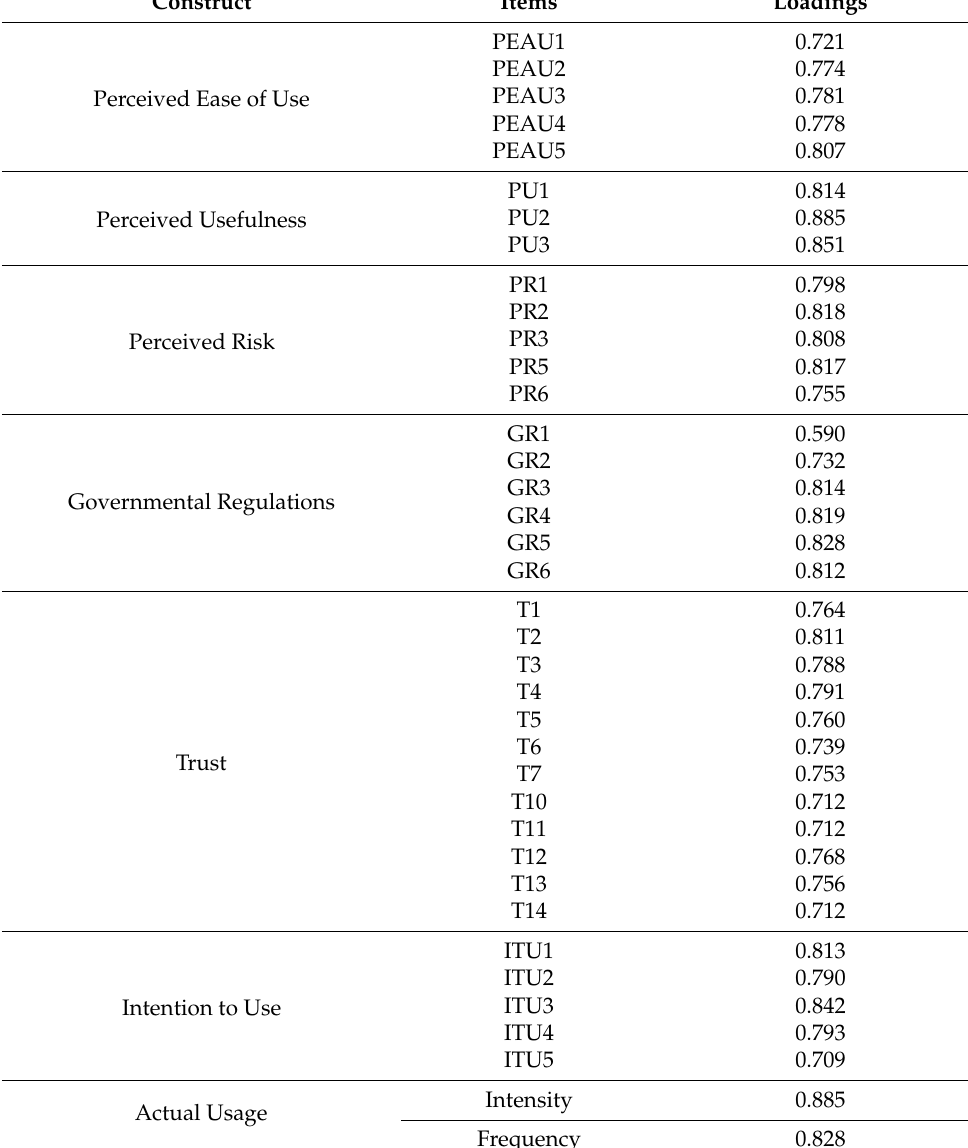
Table 2. Convergent Validity of Seven